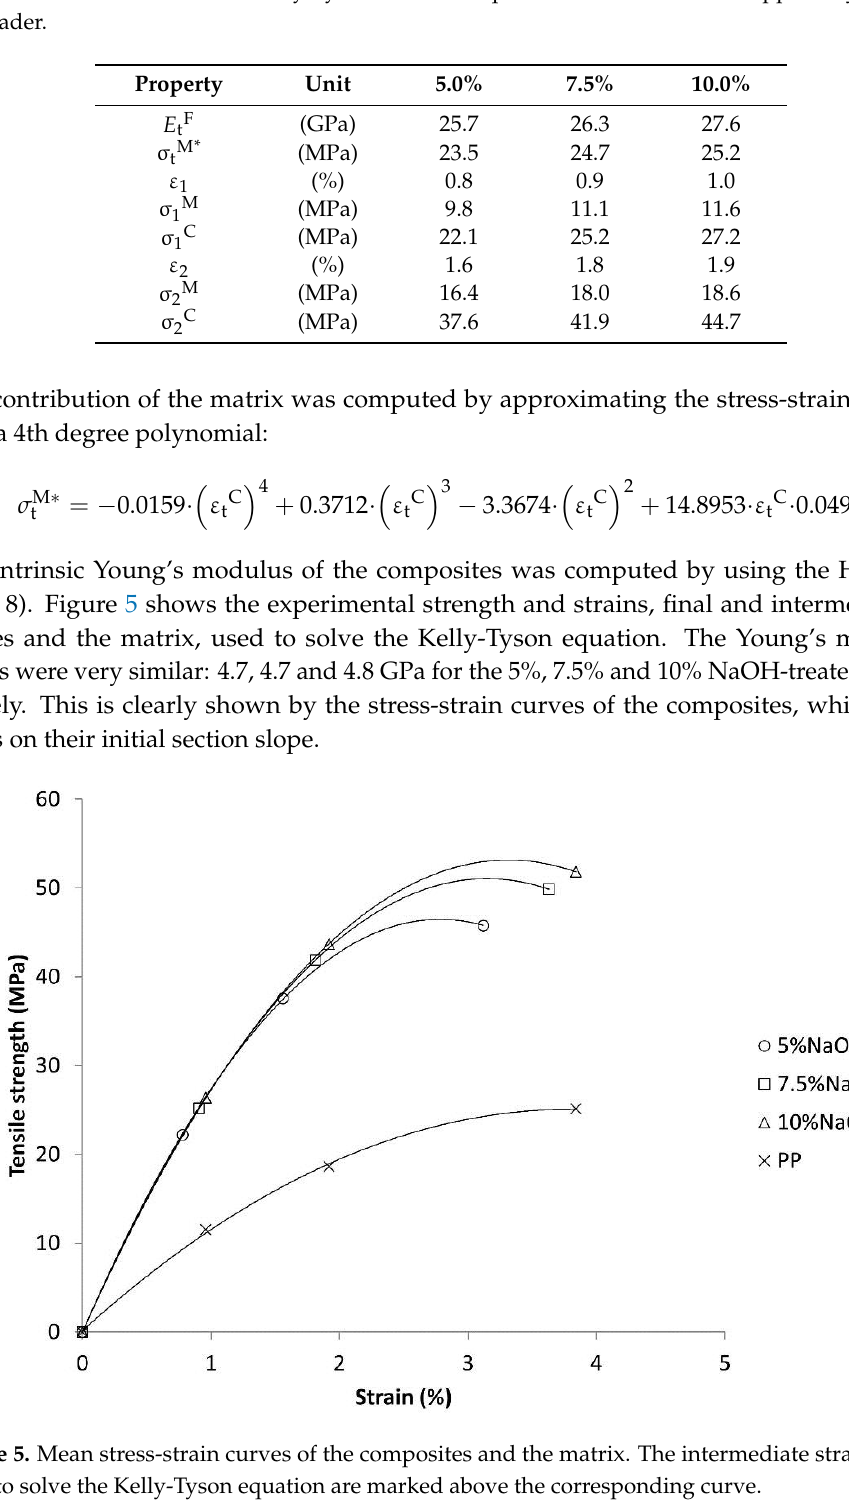
Table 5. Micro-mechanic properties of the reinforcing fibers and the interphase.